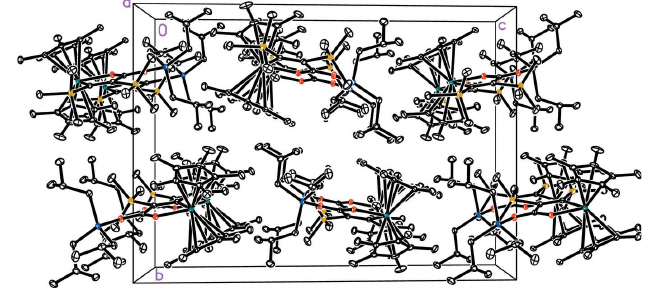
Figure 1 The molecular structure of the title complex 2 with the atom labelling. Displacement ellipsoids correspond to the 30% probability level. H atoms have been omitted for clarity. The minor disorder component is indicated by open bonds.